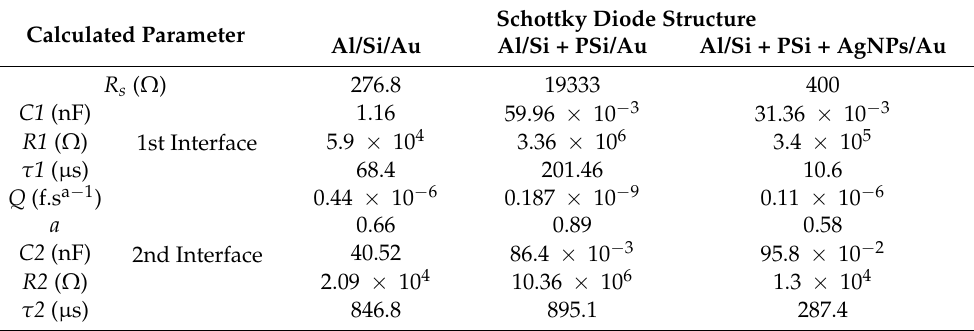
Table 2. Comparison between the electrical parameters between the interfaces of the three Schottky diodes studied in this study. The inhomogeneous structure and roughness of the surface of the second